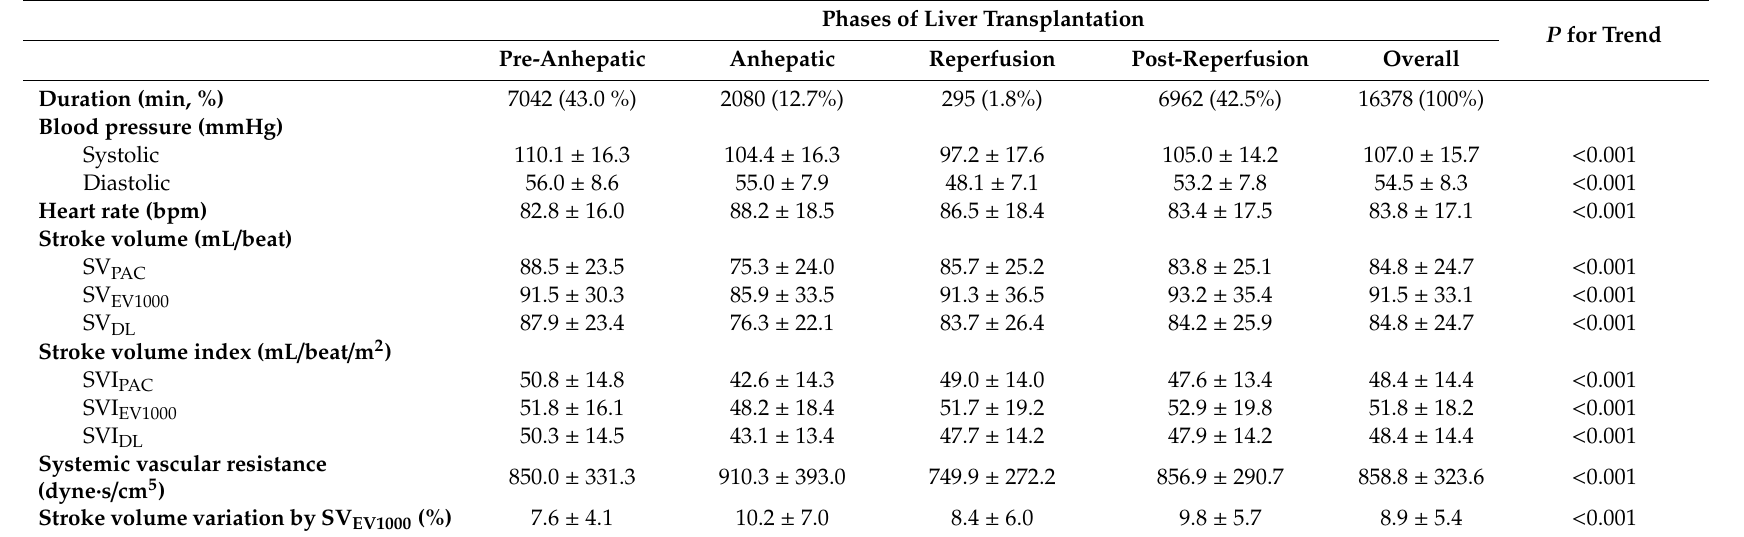
Table 2. Trends of hemodynamic parameters during the liver